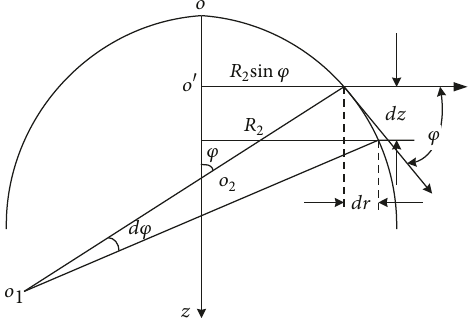
Figure 2: The geometric relation of rotational shell.